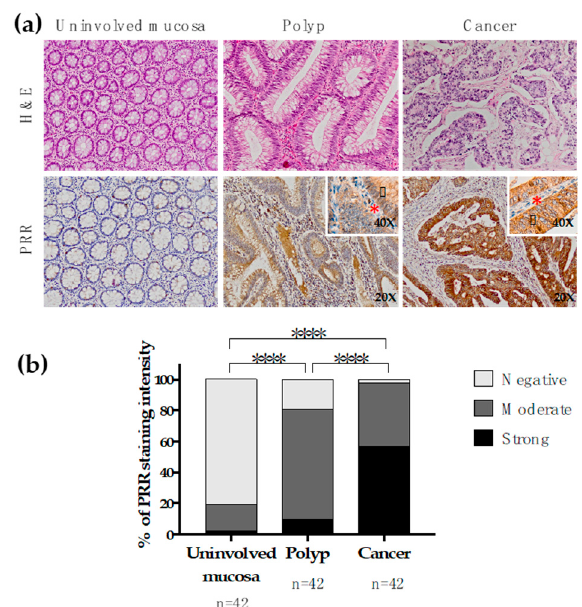
Figure 1. Immunohistochemical PRR staining along the adenomatous polyp-cancer sequence of CRC. ( a ) Representative fractions of uninvolved colonic mucosa, polyp and cancer tissue of 42 CRC patients were immunohistochemically stained with an antibody against PRR. Granular cytoplasmic staining was observed in neoplastic cells (black arrowhead). Stromal cellularity (lymphocytes and fibroblasts) did not express PRR (red asterisk). ( b ) PRR staining intensity was scored as negative, moderate or strong. The scores were quantified in each tissue type and statistical significance of the PRR intensity pattern among the different tissues was determined by Chi-Square test. H&E: Hematoxylin and Eosin staining. PRR: (pro)renin receptor staining. Table 2. Immunohistochemical PRR staining according to CRC histologic subtypes. Representative fractions of intestinal-type, mucinous and signet ring cell carcinomas were immunohistochemically stained in the centre of the tumour, tumour front, local metastasis and distant metastasis. PRR staining intensity was scored as negative, moderate or strong. The scores were quantified in each histologic subtype and statistical significance was determined by Chi-Square test. Tumour